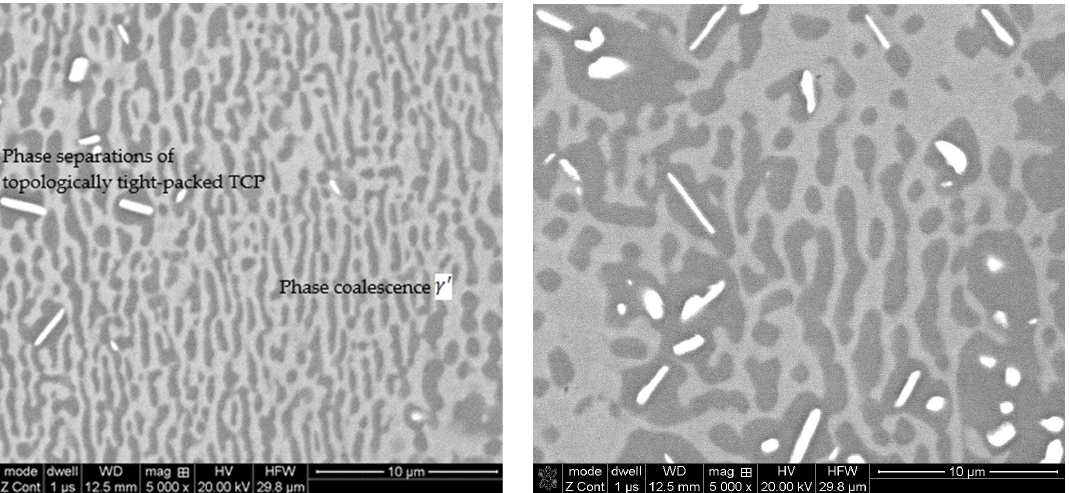
Figure 16. The microstructure of the γ / γ ’ phases in the parent material on the leading edge of the blade covered with an APS type protective coating.